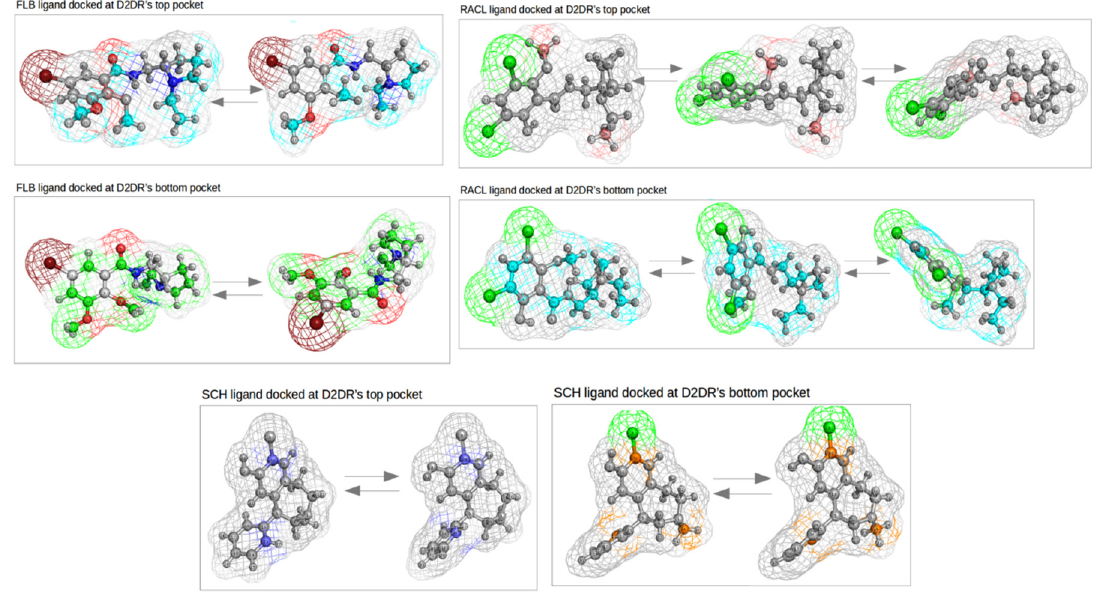
Figure 9. The most prominent motions extracted from PCA measurements for the three sets of ligands.